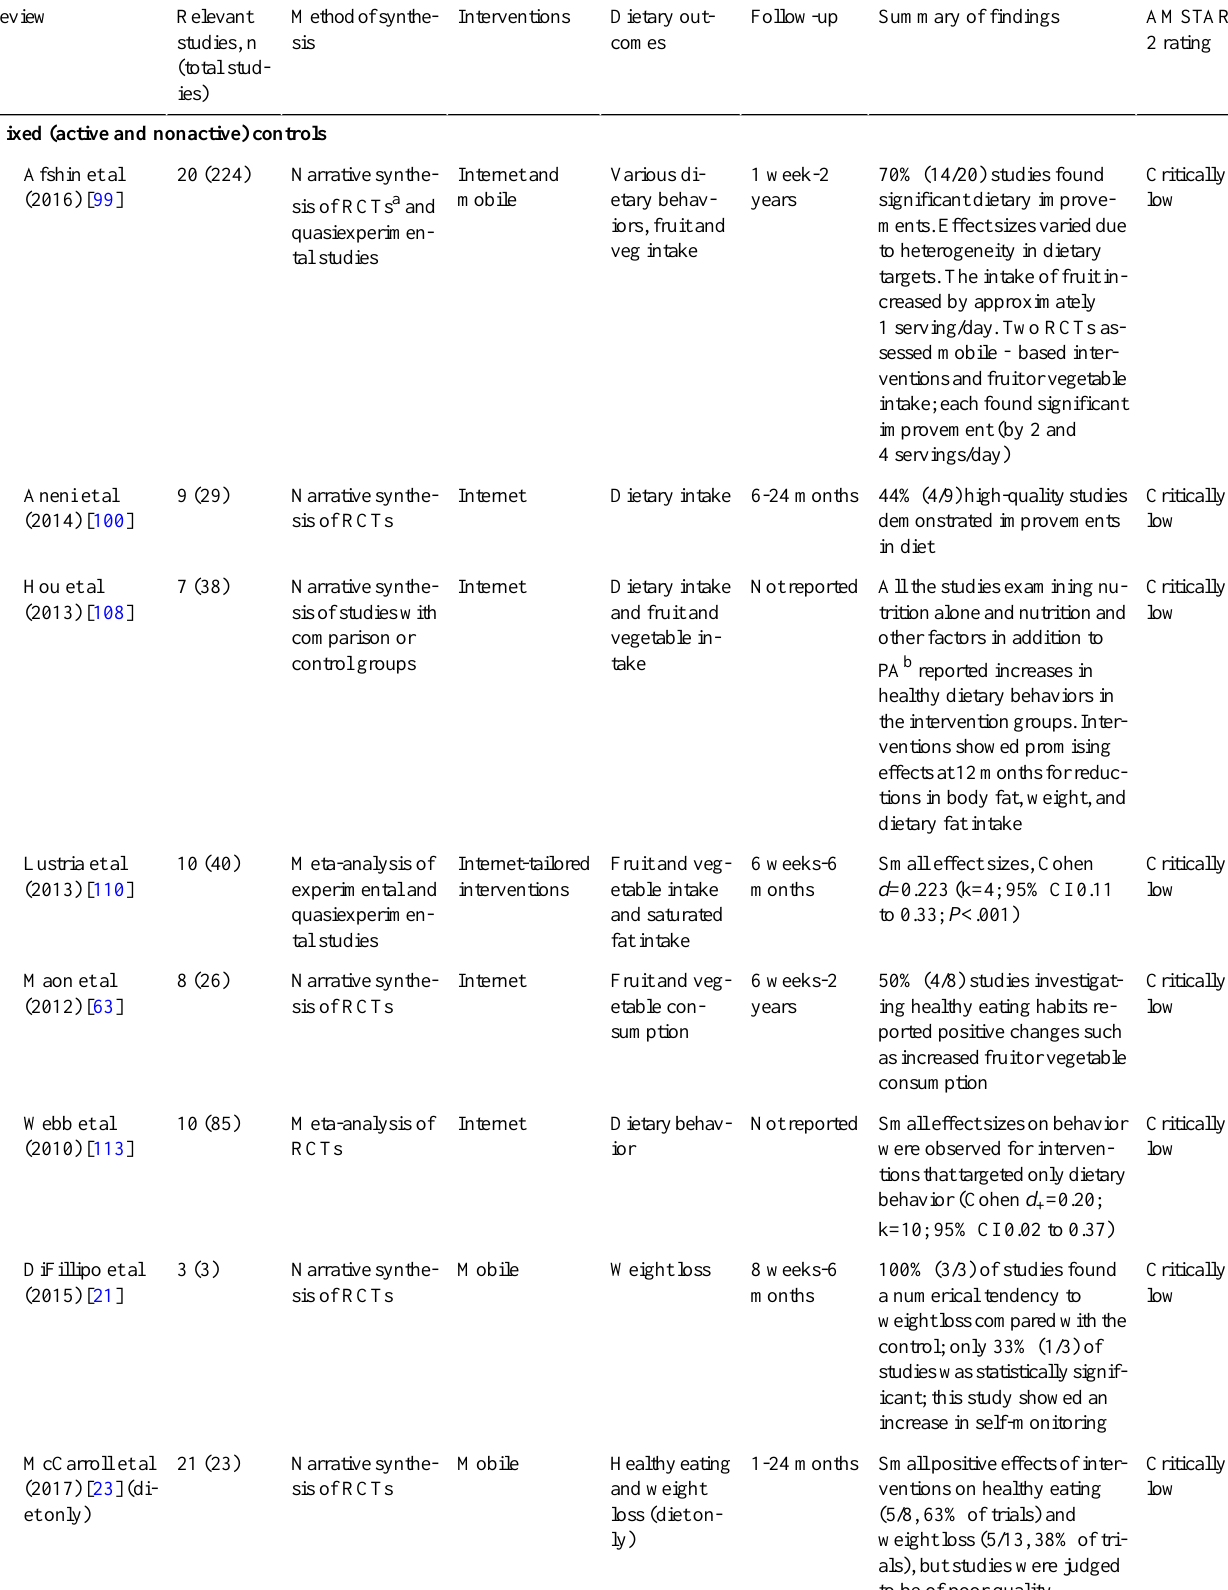
Table 3. Results of reviews on diet, ordered by type of control and mode of delivery of intervention.